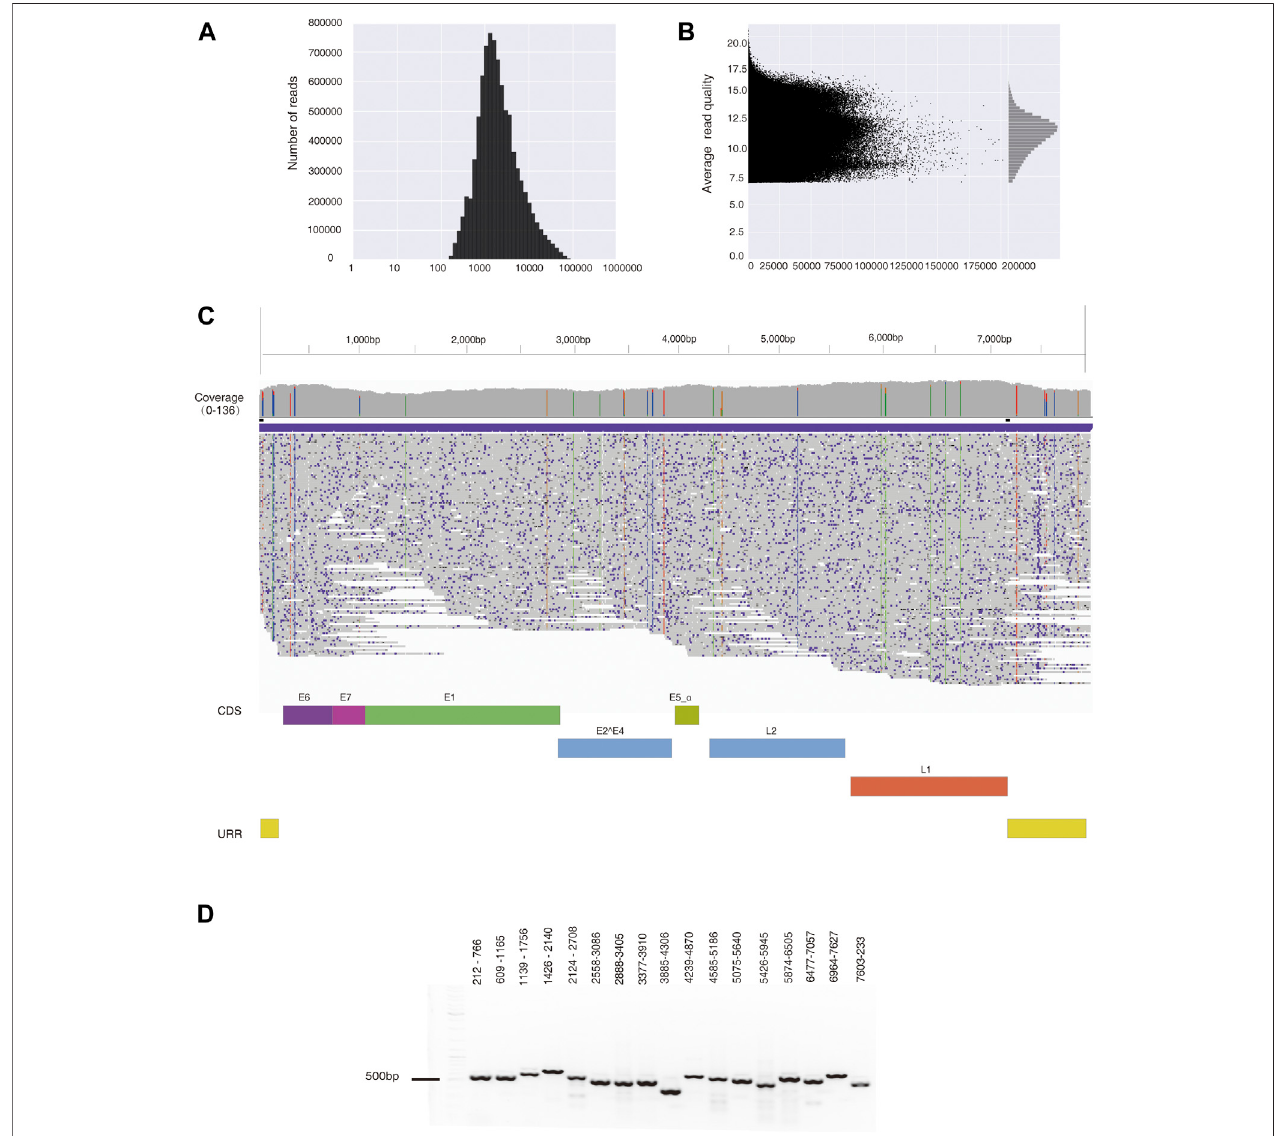
FIGURE2| HPV35genomewasassembledfromdatageneratedbynanoporesequencingandfurtherampli fi edbyPCR. (A) Thedistributionofreadsgeneratedby nanopore sequencing from a cervical cancer tissue sample. (B) The distribution of the read quality of nanopore sequencing data. (C) De novo assembly of the HPV35 genome from 678 reads generated by nanopore sequencing, which is shown in the Integrative Genomics Viewer (IGV). (D) Seventeen HPV35 genomic segments were ampli fi ed from DNA extracted from a cervical cancer tissue